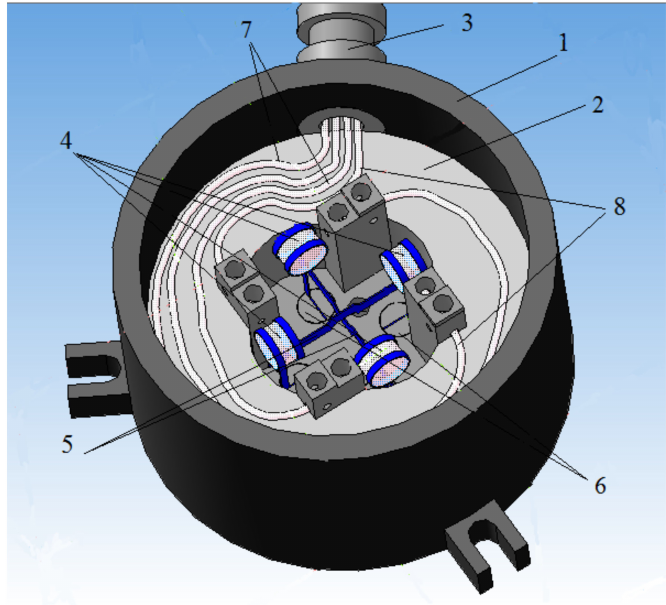
Figure 1. 3D-model of two-coordinate FOAS. 1—body, 2—base, 3—fitting, 4—optically modulating element-cylindrical lens, 5—elastic element, 6—adjustment unit, 7—optical fibers of the X axes, 8—optical fibers of the Y axes.